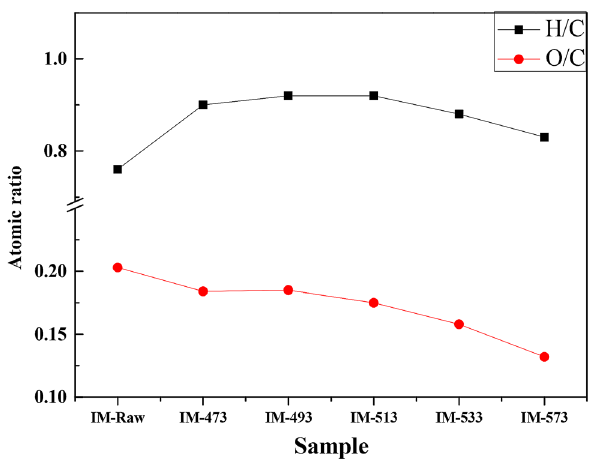
Fig. 2 Variation of H/C and O/C during hydrothermal treatment